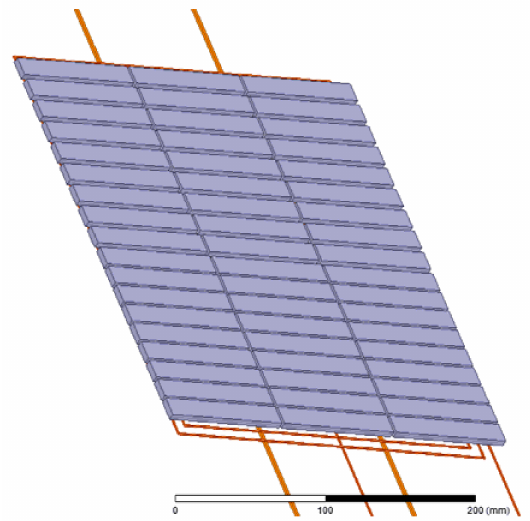
Figure 14. Model with placement of the magnetic strip.